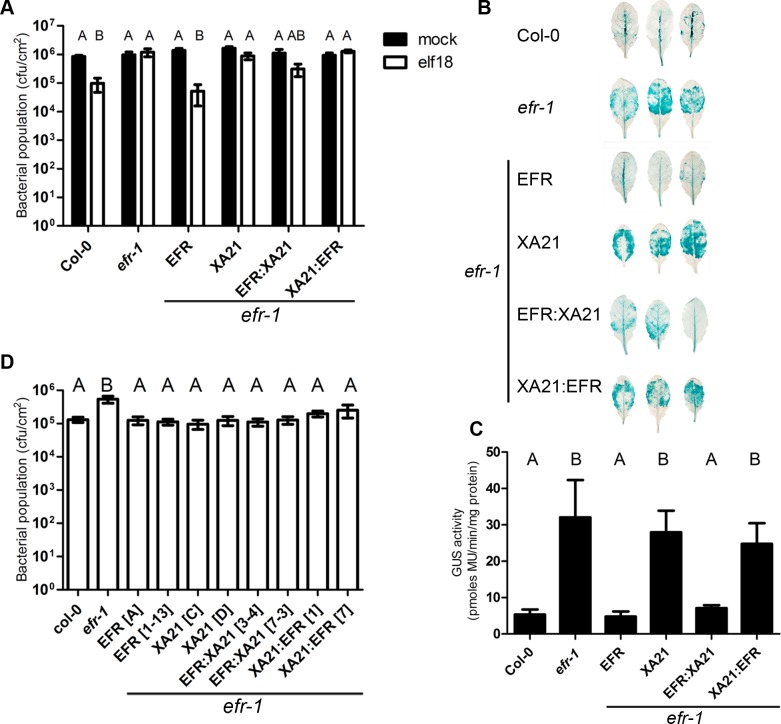
Bacterial resistance conferred by EFR, XA21 and chimeric receptors in A. thaliana.A. Elf18-induced resistance in A. thaliana Col-0, efr-1 and efr-1 transgenic homozygous lines stably expressing EFR:GFP, EFR:XA21:GFP, XA21:GFP or XA21:EFR:GFP under the control of the 35S promoter. Plants were pre-treated with mock (water) or 1 μM elf18 for 24 h before infection with Pto DC3000 (OD600 = 0.0002). Bacterial populations were scored at 2 dpi. Values are averages ±SE (n = 4). Infections were repeated four times with similar results. B. Agrobacterium-mediated transient expression of a 35S::GUS transgene in A. thaliana Col-0, efr-1 and efr-1 transgenic homozygous lines stably expressing EFR:GFP, XA21:GFP, EFR:XA21:GFP or XA21:EFR:GFP under the control of the 35S promoter. Leaves were stained for GUS activity at 3 dpi. Leaves shown are representative of the variation in GUS staining observed. The experiment was repeated four times with similar results. C. Fluorimetric quantification of GUS activity. Values are averages ±SE (n = 6). The experiment was repeated three times with similar results. D. Susceptibility of A. thaliana Col-0, efr-1 and efr-1 transgenic homozygous lines stably expressing EFR:GFP, XA21:GFP, EFR:XA21:GFP, or XA21:EFR:GFP under the control of the 35S promoter to Pto DC3000 COR− (OD600 = 0.2; spray inoculation). Bacterial populations were scored at 3 dpi. Values are averages ±SE (n = 4). Different letters indicate significantly different values at p <0.05 (one-way ANOVA). The experiment was repeated 5 times with similar results.